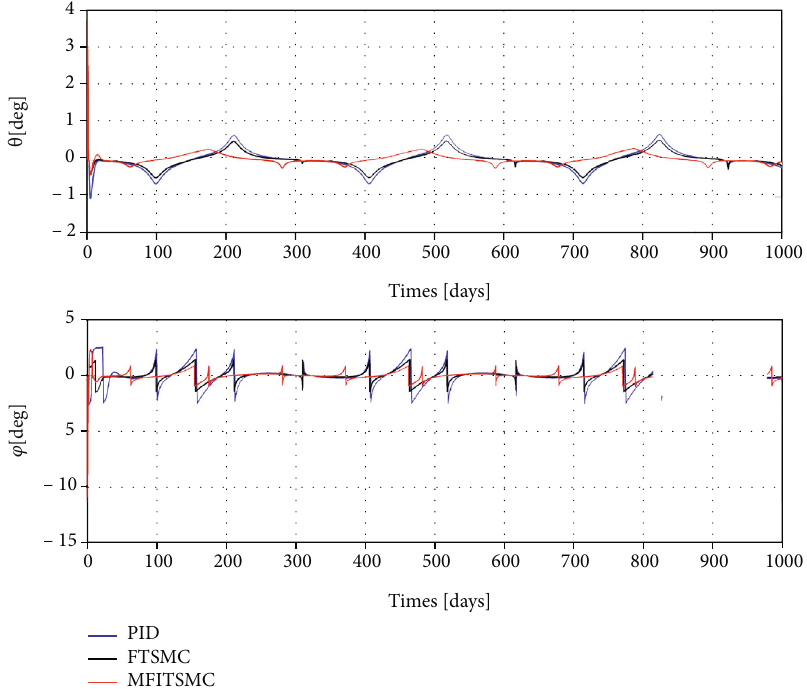
Figure 13: The time histories of the attitude angles (Follower